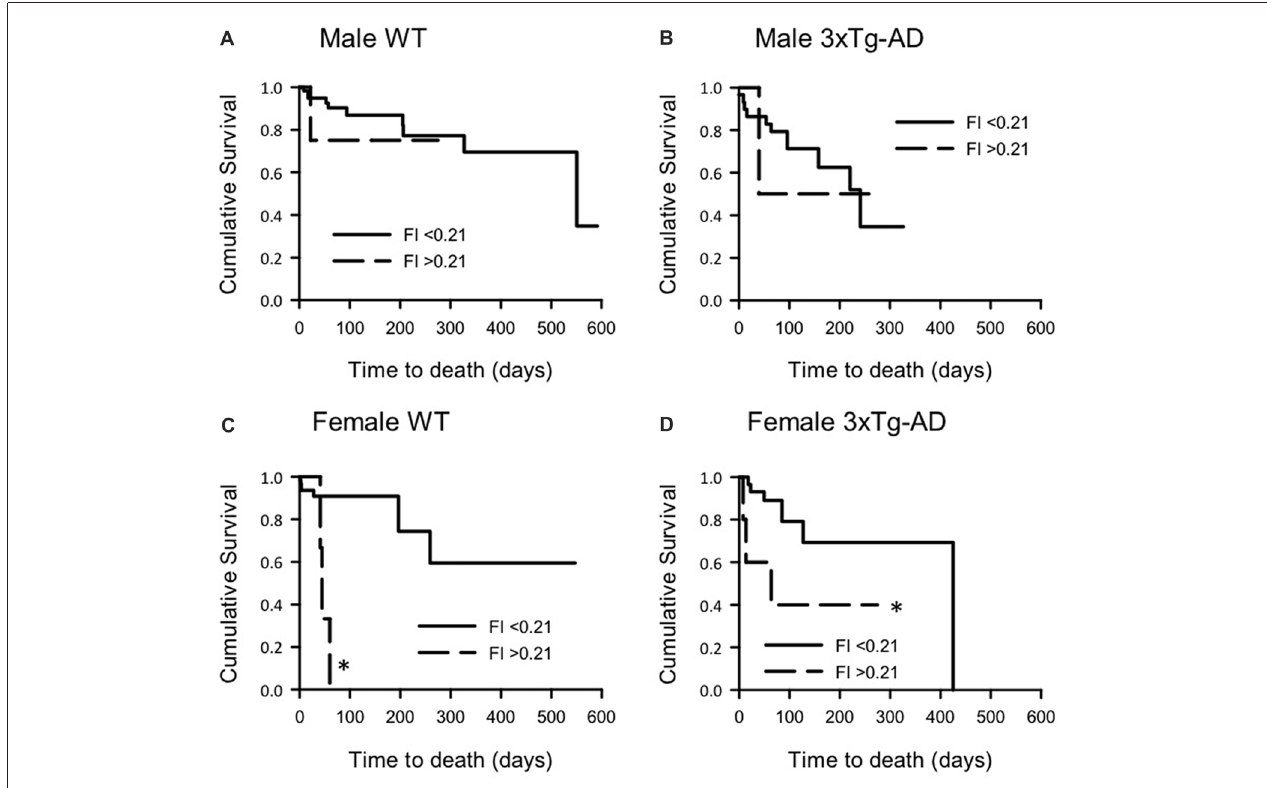
FIGURE 4 | Kaplan-Meier survival curves for male and female 3xTg-AD and WT mice with low and high FI scores. Survival curves for (A) male WT, (B) male 3xTg-AD, (C) female WT and (D) female 3xTg-AD mice split into those with low ( < 0.21) and high ( ≥ 0.21) FI scores. Survival (days) post FI score was plotted. Log rank analysis was used to compare curves and showed that, for female mice of both groups, higher FI scores were associated with shorter survival times ( p < 0.01). A similar trend was also seen for males but this was not statistically significant. ∗ p < 0.05 compared to corresponding low FI group. Male WT low FI n = 66, high FI n = 10; Male 3xTg-AD low FI n = 30, high FI n = 3; Female WT low FI n = 74, high FI n = 10; Female 3xTg-AD low FI n = 48, high FI n =